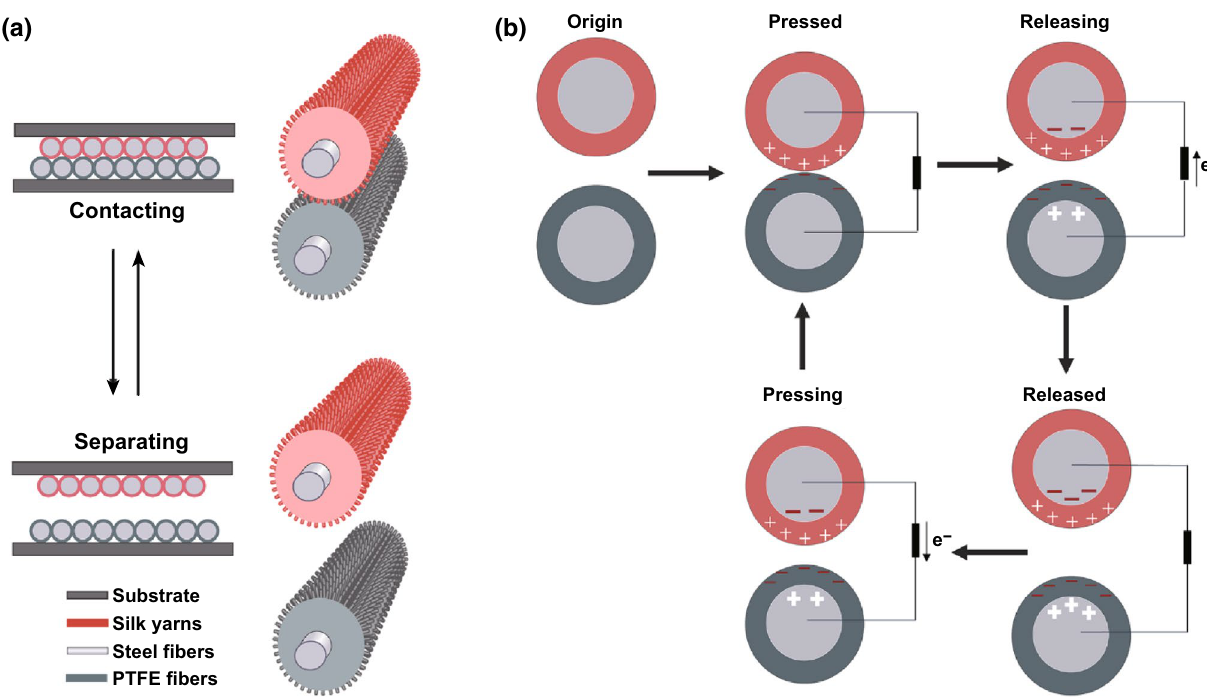
Fig. 2 Schematic illustration and working principle of SF/PTFEF EHT: a schematic diagram of SF/PTFEF EHT during working. b schematic illustration of charge generation and transfer of contact–separation mode of SF/PTFEF EHT during contacting and